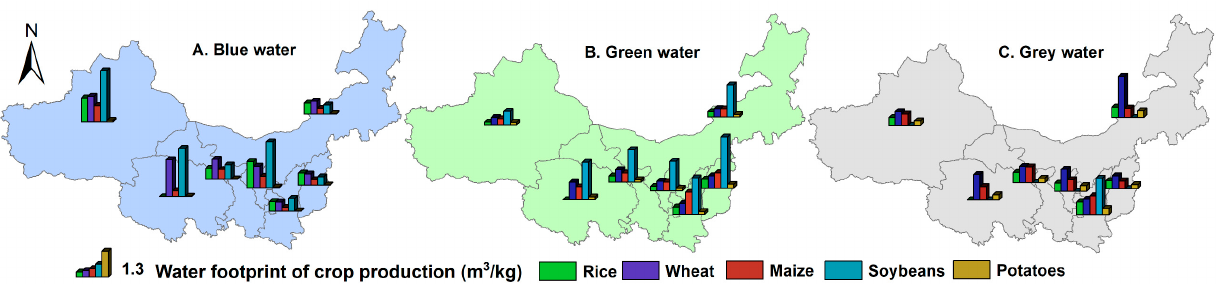
Figure 8. Spatial distribution characteristics of the water footprint of grain production. Note: ( A – C ) show the blue water, green water and grey water footprints of crop production, respectively.